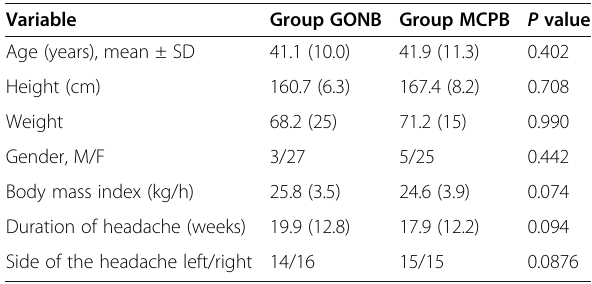
Table 1 Demographic and clinical characteristics of patients